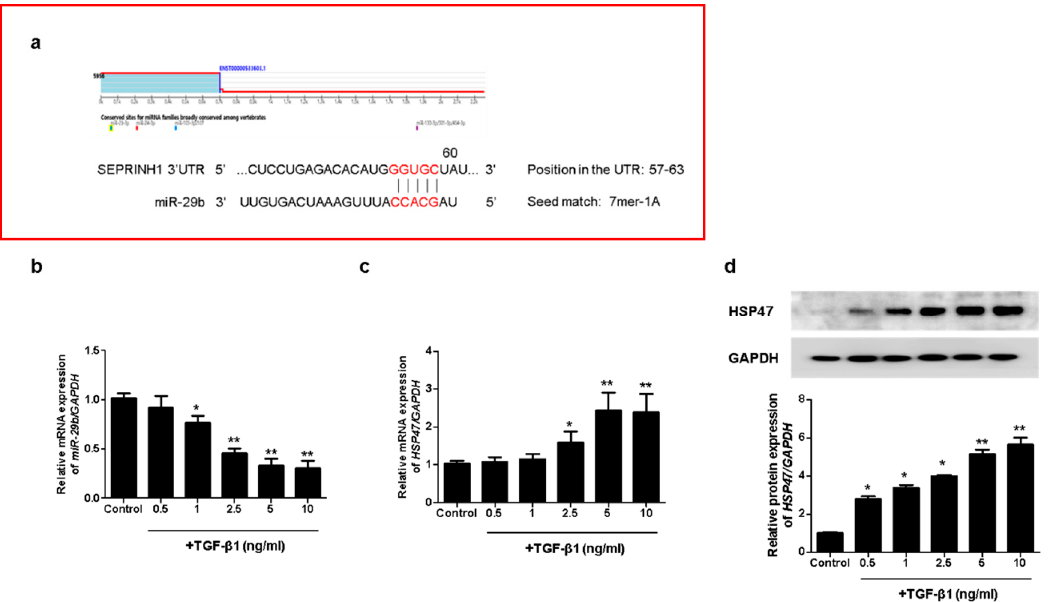
Figure 1. TGF- β 1 reduced miR-29b and induced HSP47 expression in A549 cells. ( a ) The putative binding sites of miR-29b and HSP47 were predicted using TargetScan (www.targetscan.org). A549 cells were treated with TGF- β 1 at the indicated doses (0.5, 1, 2.5, 5 or 10 ng/mL, 24 h). ( b ) miR-29b and ( c ) HSP47 mRNA expression were measured using qPCR. A549 cells were treated with TGF- β 1 (1 ng/mL) at the indicated dose (0.5, 1, 2.5, 5 or 10 ng/mL, 72 h). ( d ) HSP47 protein expression was measured using Western blotting. Data are expressed as the mean ± SEM of three independent experiments. * p < 0.05 vs. control, ** p < 0.001 vs. control.